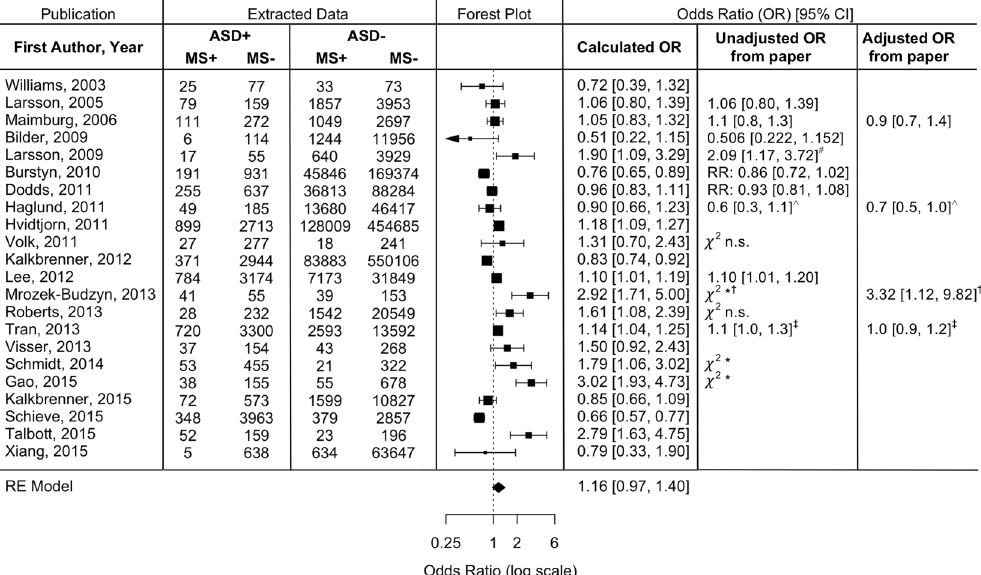
Figure 3. Meta-analysis of the association between maternal smoking during pregnancy and ASD risk based on 22 observational studies. The pooled OR using a random-effects model was found to be 1.16 (95% CI: 0.97–1.40). Data extracted from the papers and ORs calculated from this data are shown, as well as unadjusted and adjusted ORs reported in the observational study publications, or an alternate statistic reported if not ORs. ASD = autism spectrum disorder; MS = maternal smoking during pregnancy; RR = relative risk; * p ≤ 0.05; n.s. = p > 0.05. # As reported for “yes” in response to maternal smoking query. Data extracted for meta-analysis combined “yes” and “yes, but stopped” responses. ∧ As reported for ASD and smoking ≥ 10 cigarettes/day. Data extracted for meta-analysis combined ASD and Asperger’s subgroups, and smoking 1–9 and smoking ≥ 10 cigarettes/day. † As reported for active maternal smoking. Data extracted for meta-analysis combined active and passive maternal smoking. ‡ As reported for smoking in all pregnancy. Data extracted for meta-analysis combined only first trimester and all pregnancy